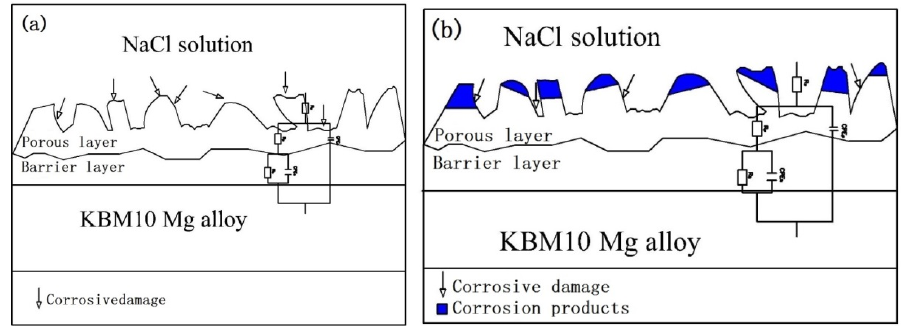
Figure 12. The model of KBM10 magnesium alloy substrate ( a ) and (350–6) PEO coating ( b ).